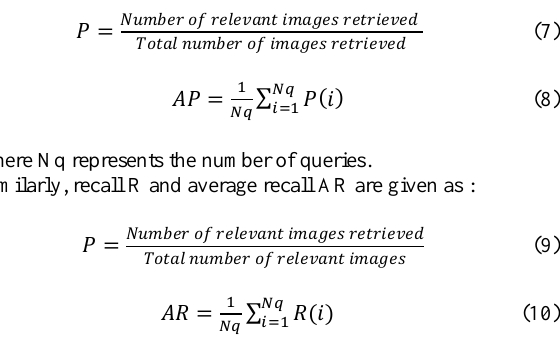
Figure 8. Precision-Recall curves obtained using the 800 samples with (in blue) and without (in red) pre-analysis